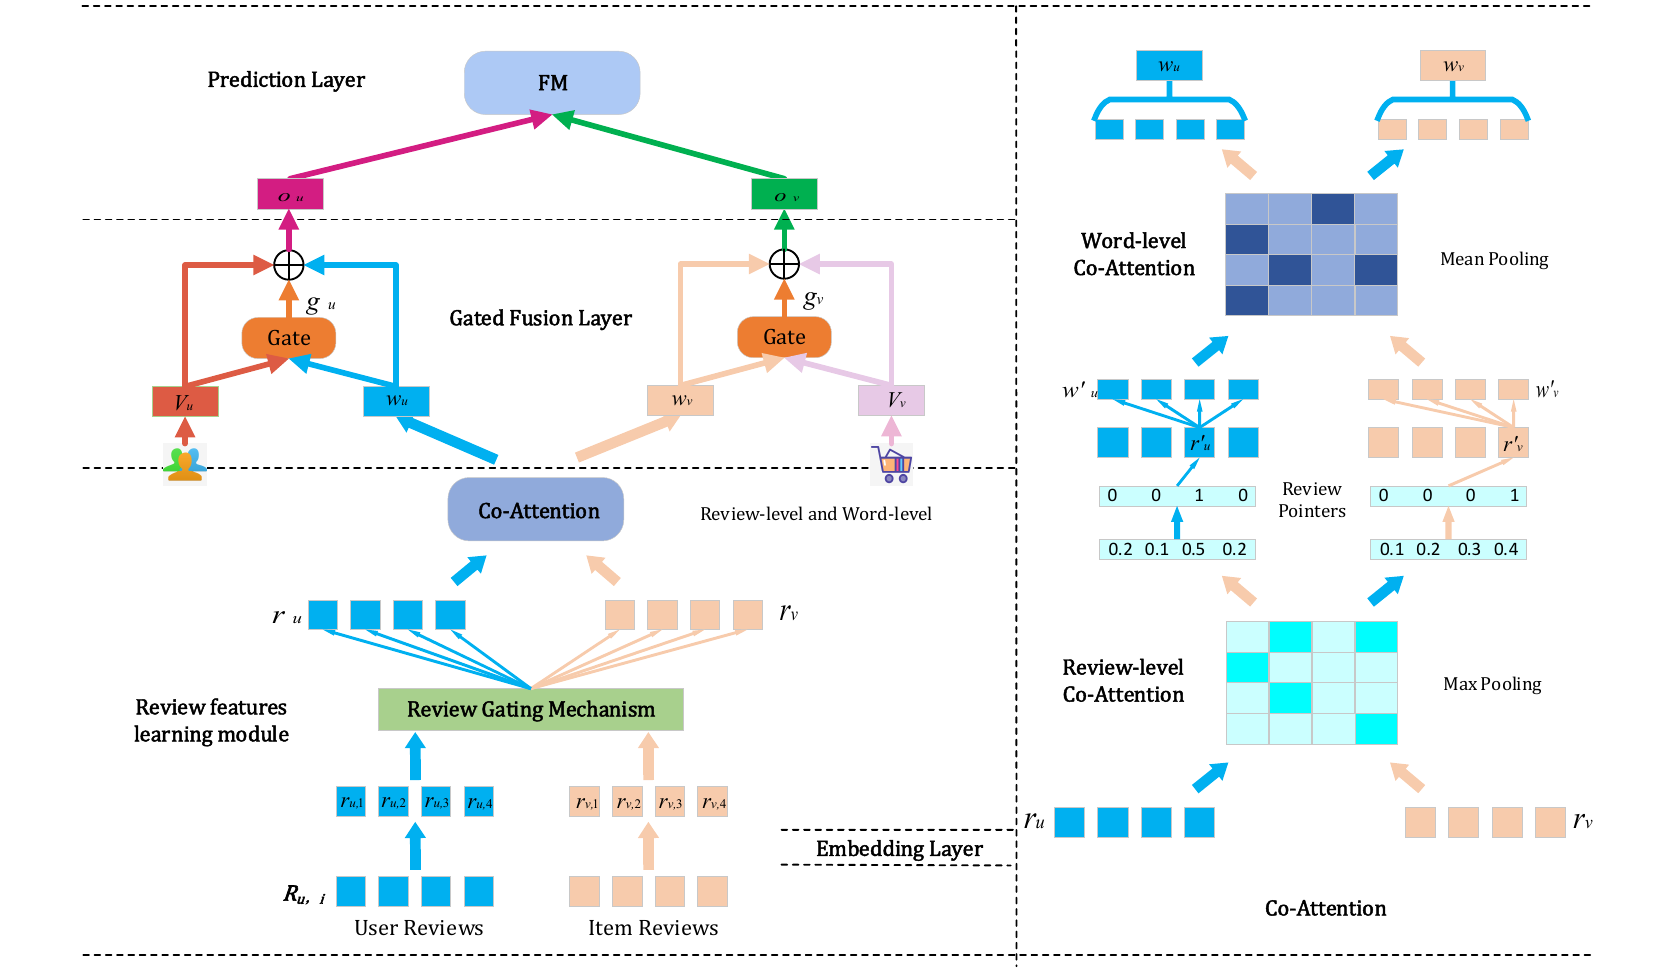
Figure 1. Neural network architecture of MPCAR.